Question: Looking at the figure, what chart type is it?
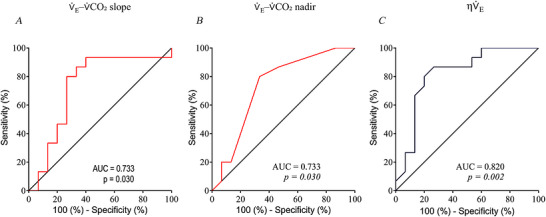
Answer: line